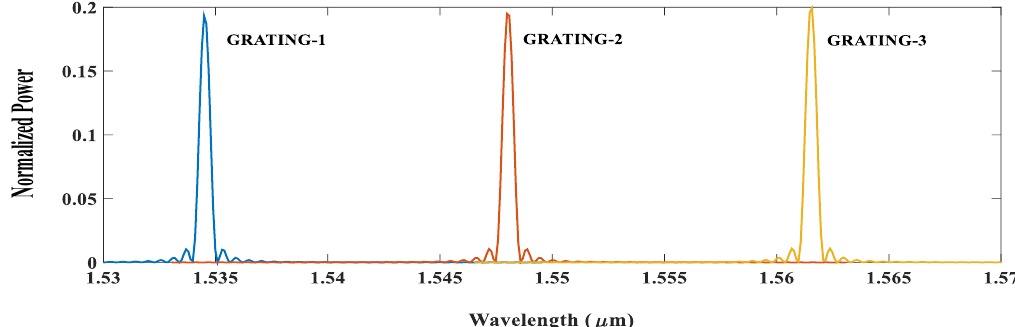
Figure 2. Reflection spectra of proposed sensor showing Bragg peaks of Grating-1, Grating-2 and